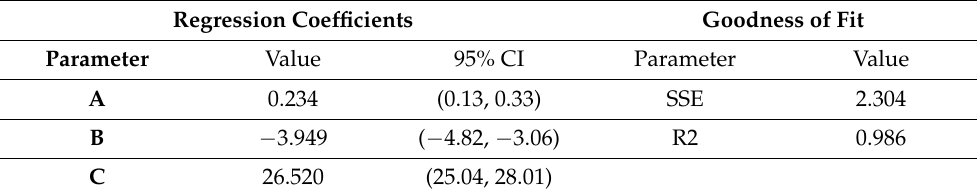
Table 1. Regression coefficients of the quadratic regression analysis between IAP and the voltage values of the reflection response of the abdominal wall phantom. The R 2 and sum of squares error (SSE) of the regression analysis are shown as well. The SSE shows the total deviation of the response values from the fit to the original values obtained by the pressure gauge. Regression Coefficients Goodness of Fit Parameter Value 95%